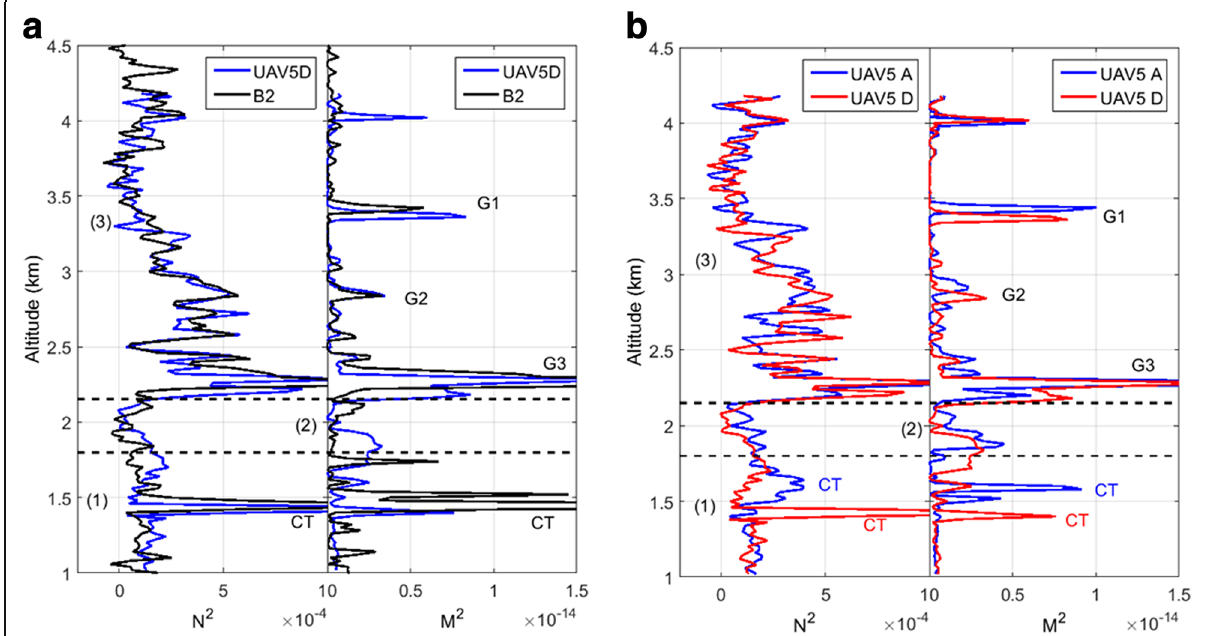
Fig. 7 a As in Fig. 6a, but for UAV5D and B2. UAV5D data are missing below 1.0 km. b As in Fig. 6,b but for UAV5. UAV5D data are missing below 1.0